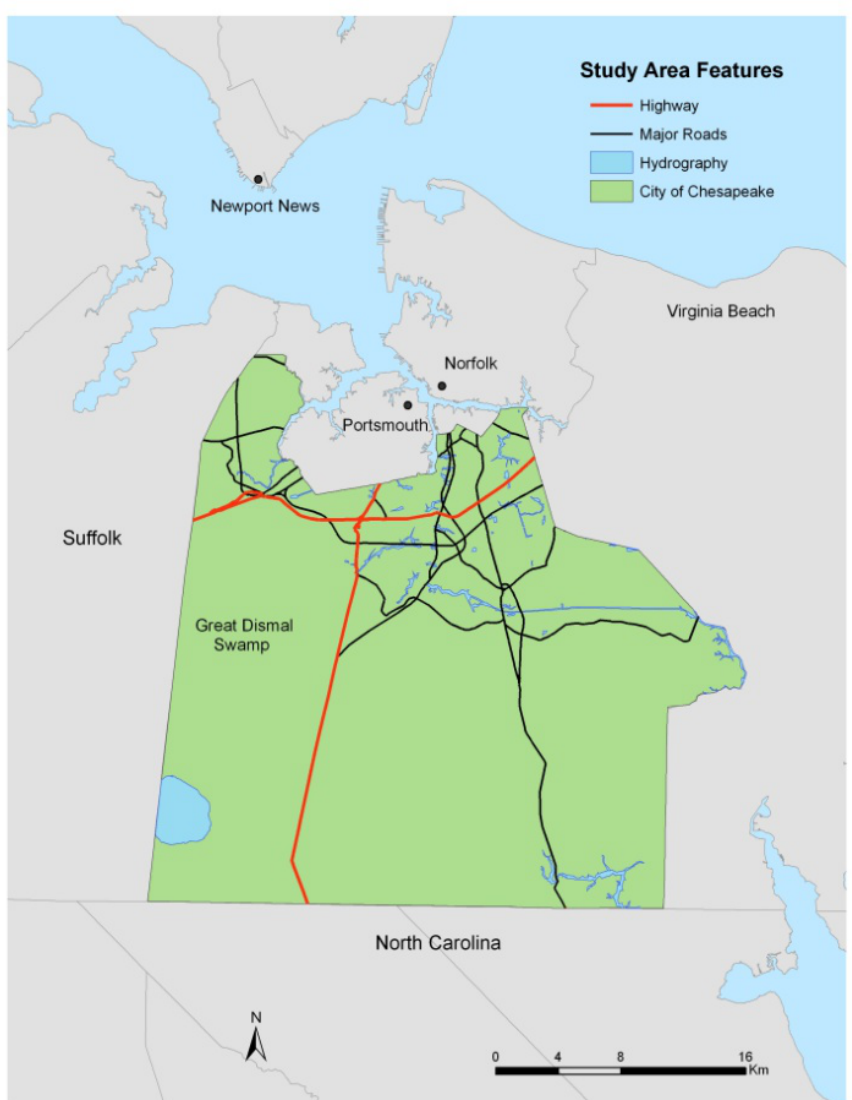
Figure 1. Study area location, City of Chesapeake, Virginia, situated on the border of the Great Dismal Swamp and the extensive estuaries of the Chesapeake Bay and its coastal